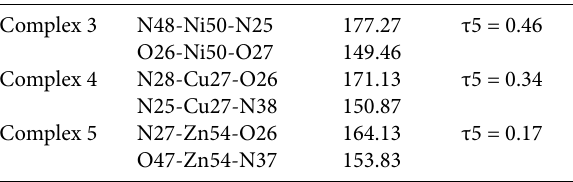
Table 1. The two greatest valence angles around metal center for the complexes 3, 4, and 5. Complex 3